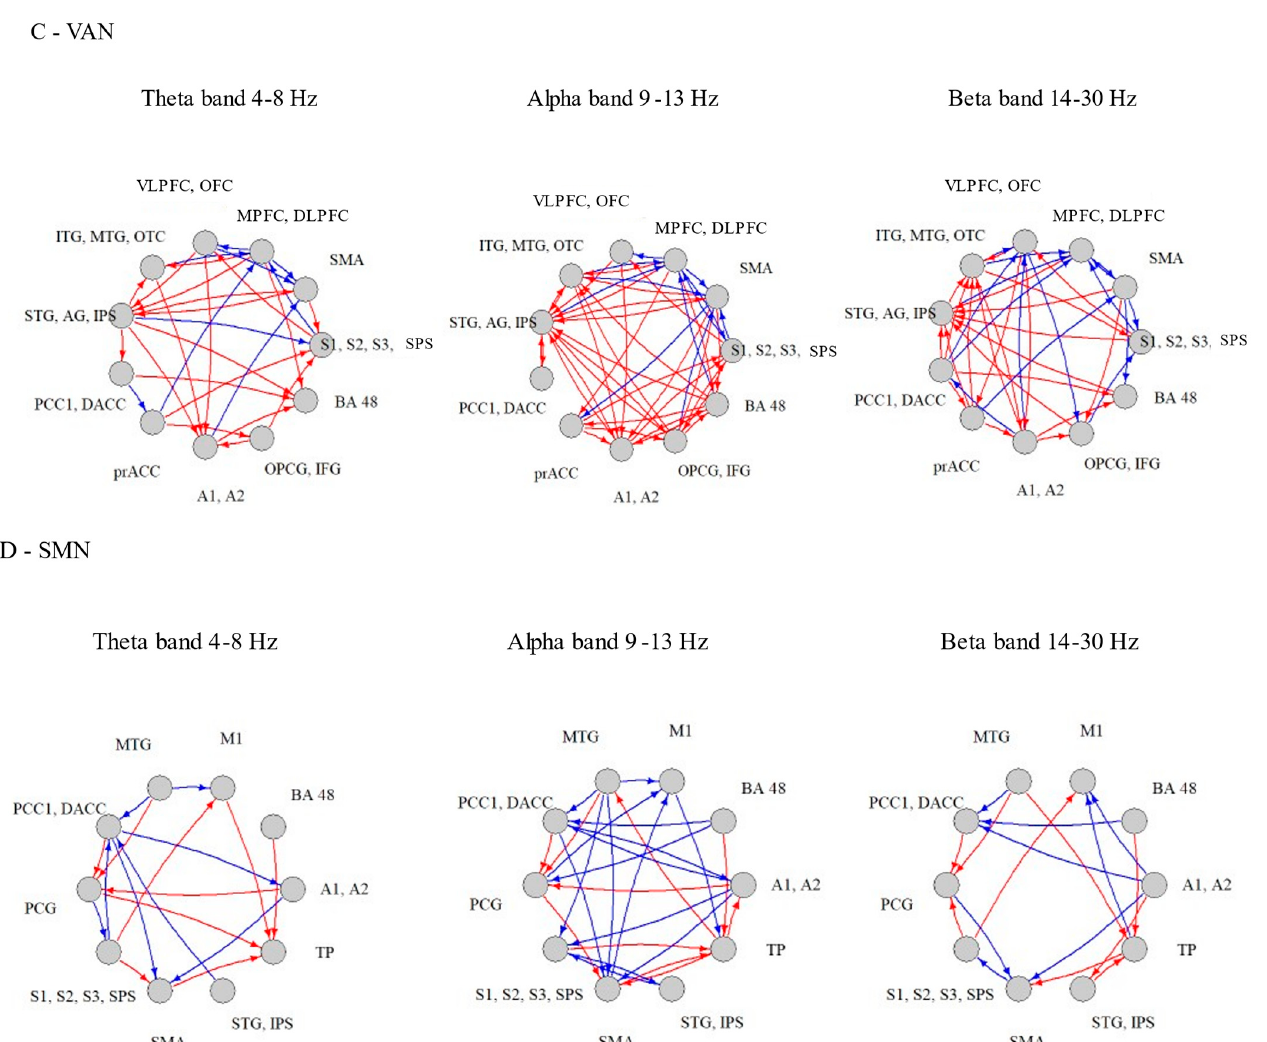
Figure 3. Comparison between HC and PD in the tPDC within each network ( A ) DAN–Dorsal Attention Network, ( B ) CEN–Central Executive Network, ( C ) VAN–Ventral Attention Network, and ( D ) SMN–Sensory Motor Network. The stronger connections in PD compared to HC are in red arrows, the weaker connections in PD compared to HC are in blue arrows.